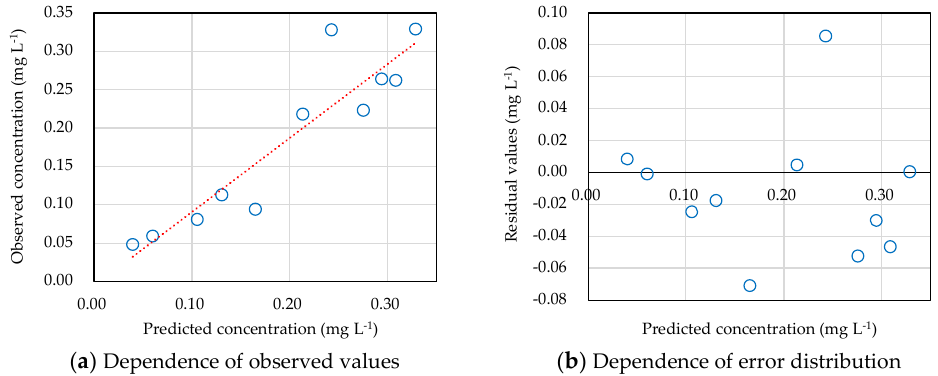
Figure 5. Analysis results of the dependence of ( a ) observed values and ( b ) error distribution on the predicted values.